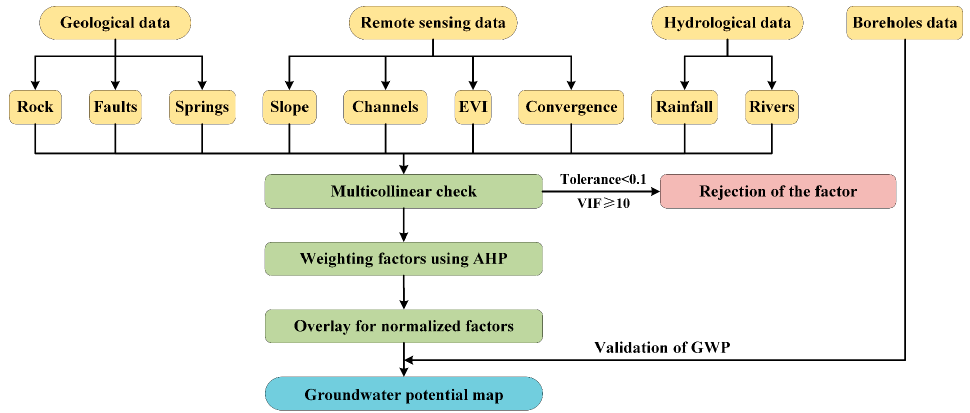
Figure 2. Flowchart of the groundwater potential assessment methodology.